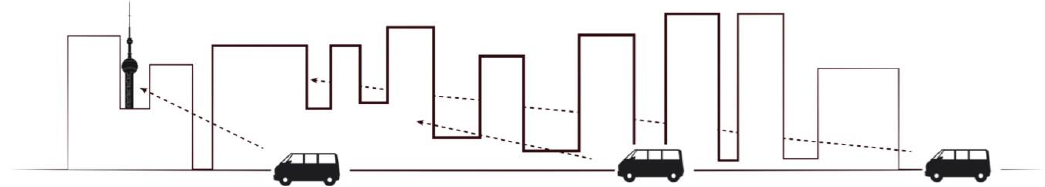
Fig.9 Repeated and continuous visual